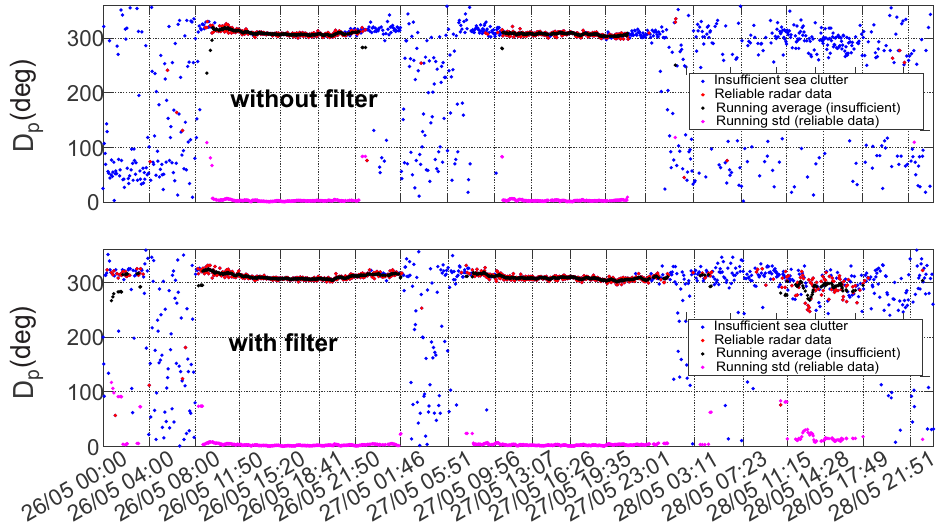
Figure 13. Time series of the peak direction before ( upper panel ) and after ( lower panel ) streak filtration given together the moving average and std, calculated with the 20 min window size.